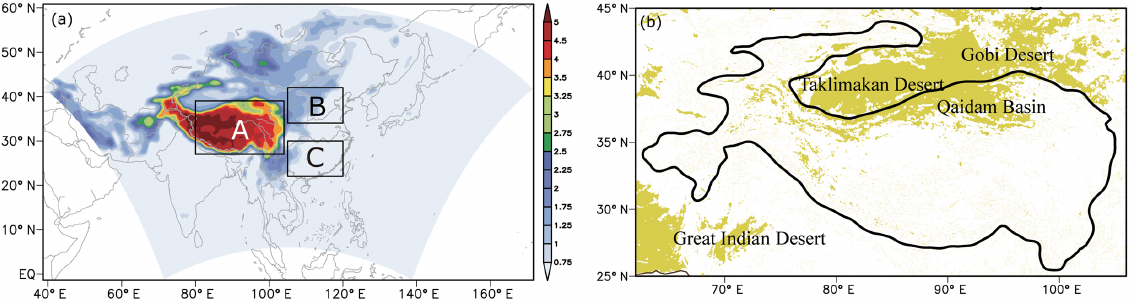
Figure 1. (a) Model domain and topography (units: km) and (b) dust source regions (yellow area) over the Tibetan Plateau and surrounding areas. Rectangles in (a) indicate Tibetan Plateau (A; 27–39 ◦ N, 80–105 ◦ E), north EASM region (B; 34–42 ◦ N, 105–120 ◦ E) and south EASM region (C; 22–30 ◦ E, 105–120 ◦ N).